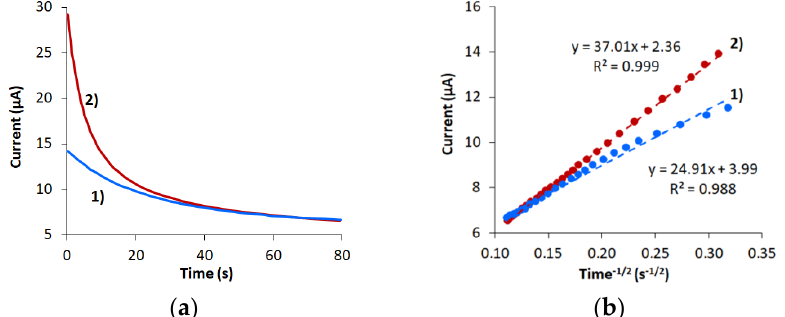
Figure 4. Chronoamperograms obtained at 0.5 V potential on CVE ( 1 ) and CVE act at 2.0 V ( 2 ) in 0.1 M KCl containing 1.0 mM K 4 [Fe(CN) 6 ] ( a ). Dependencies i = f(t − 1/2 ) are obtained from chronoamperograms on the corresponding electrodes ( b ).